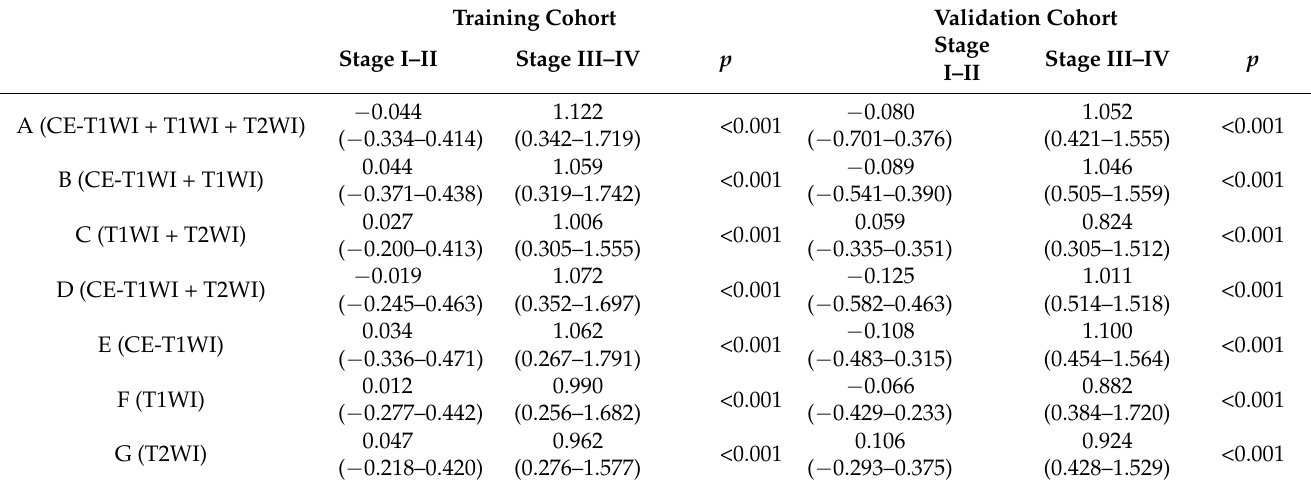
Table 3. The median of Rad-scores based on different sequences.